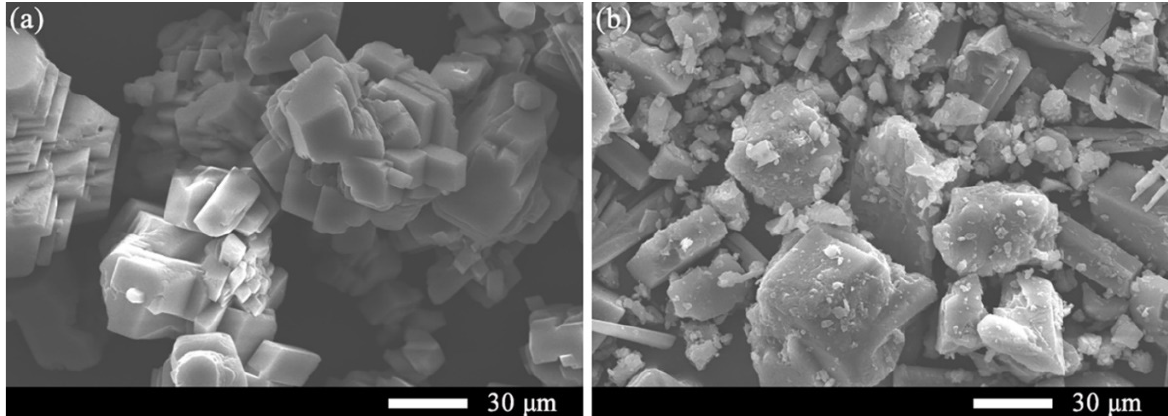
Figure 10. SEM of calcium carbonate crystals; ( a ) calcium carbonate crystal before adding copolymer; ( b ) calcium carbonate crystal after adding copolymer .